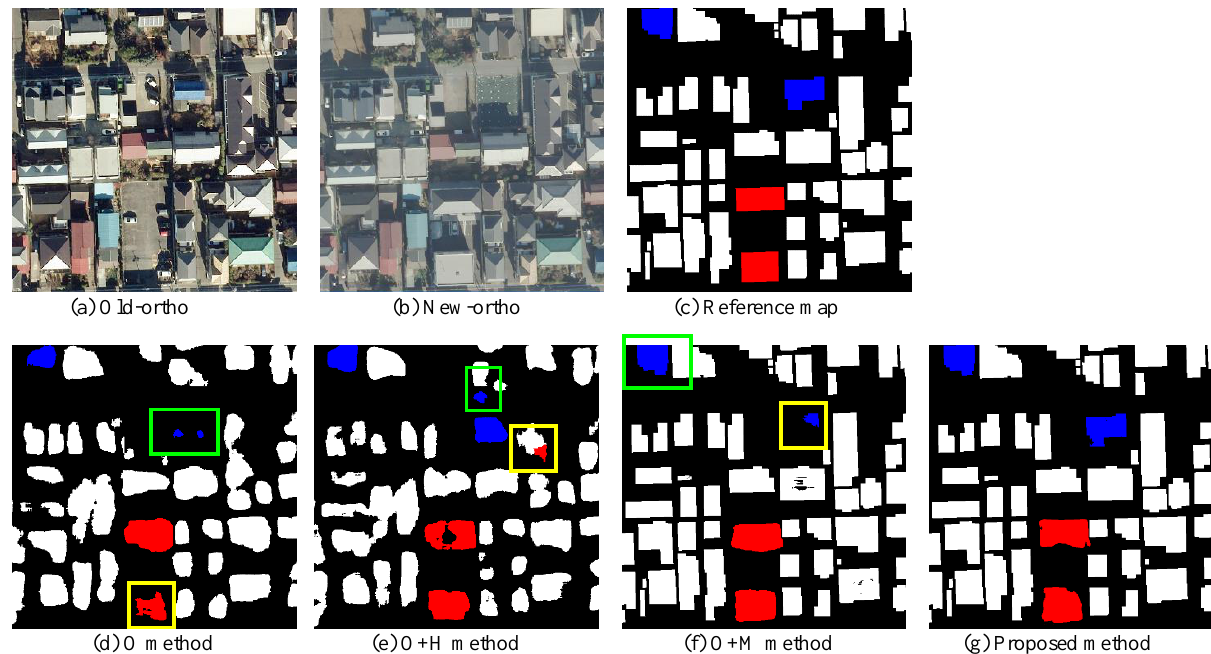
Figure 3. Examples of building change detection using different methods (100 m  100 m) (red: new; blue: demolished; white: other buildings; black: